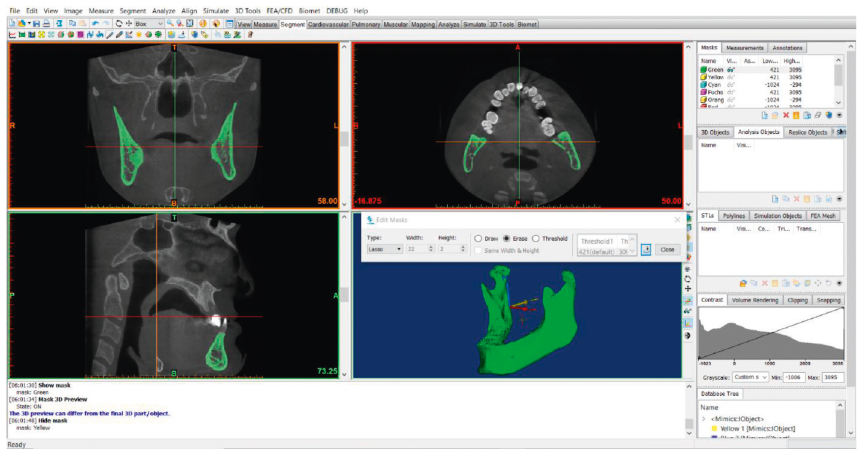
Figure 3: The mandibular bone after segmentation using edit mask tool.